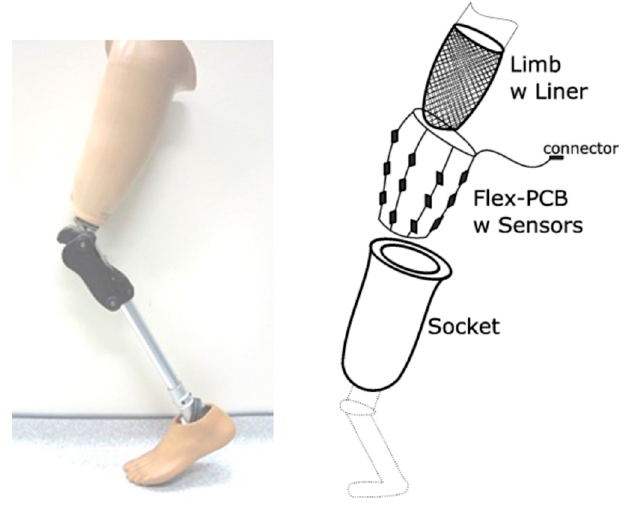
Figure 1. Schematic principle of pressure mapping enhanced lower-limb prosthesis. The flexible electronic system can be temporarily inserted in raw sockets to acquire high resolution data.